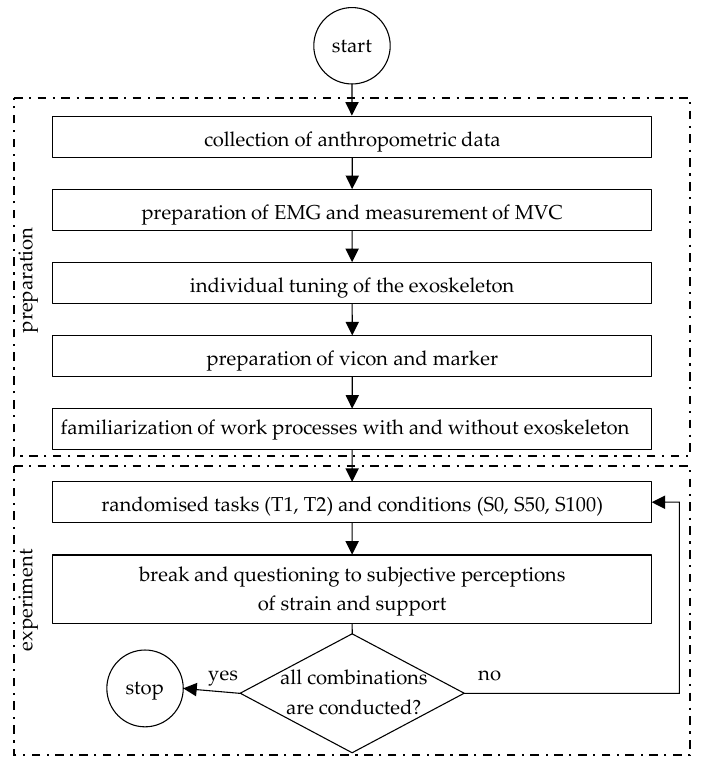
Figure 4. Test procedure.